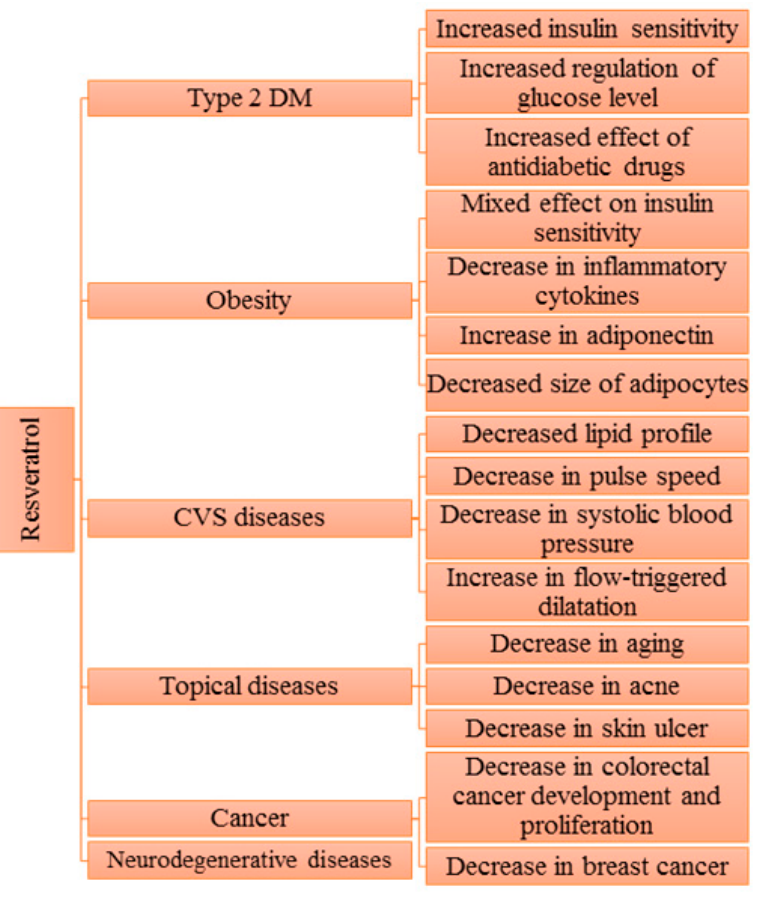
Figure 2. Short review of the resveratrol effects in clinical trials in patients suffering from type 2 diabetes mellitus, obesity, cardiovascular diseases (CVD) disease, skin disorders or cancer. Table 1. Clinical findings on diseased participants treated with resveratrol.